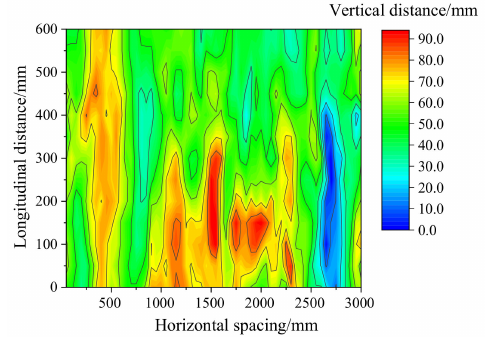
Figure 3. Ground flatness cloud atlas of a jujube fruit